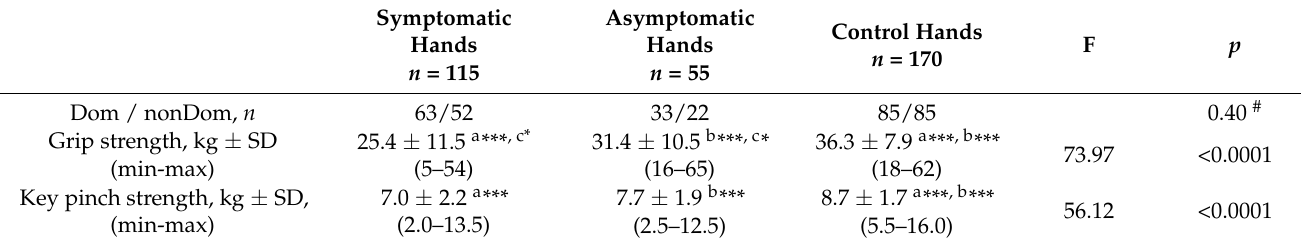
Table 3. Comparison of hand strength between symptomatic hands, asymptomatic hands in patients with NTOS and hand controls (Kruskal–Wallis test followed by Dunn post hoc